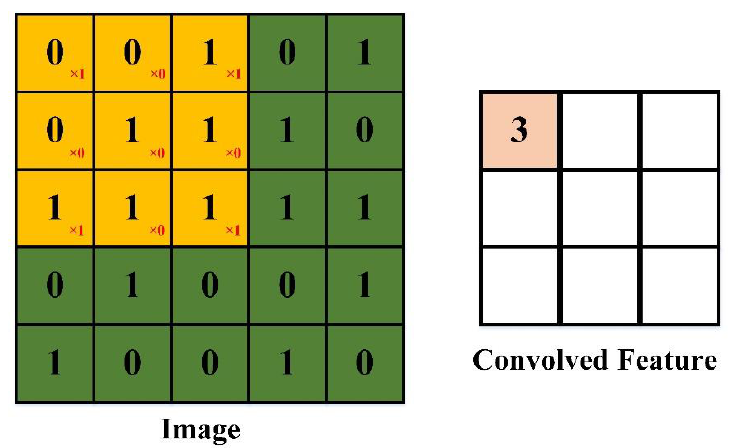
Figure 2. Schematic illustration of convolutional neural networks.